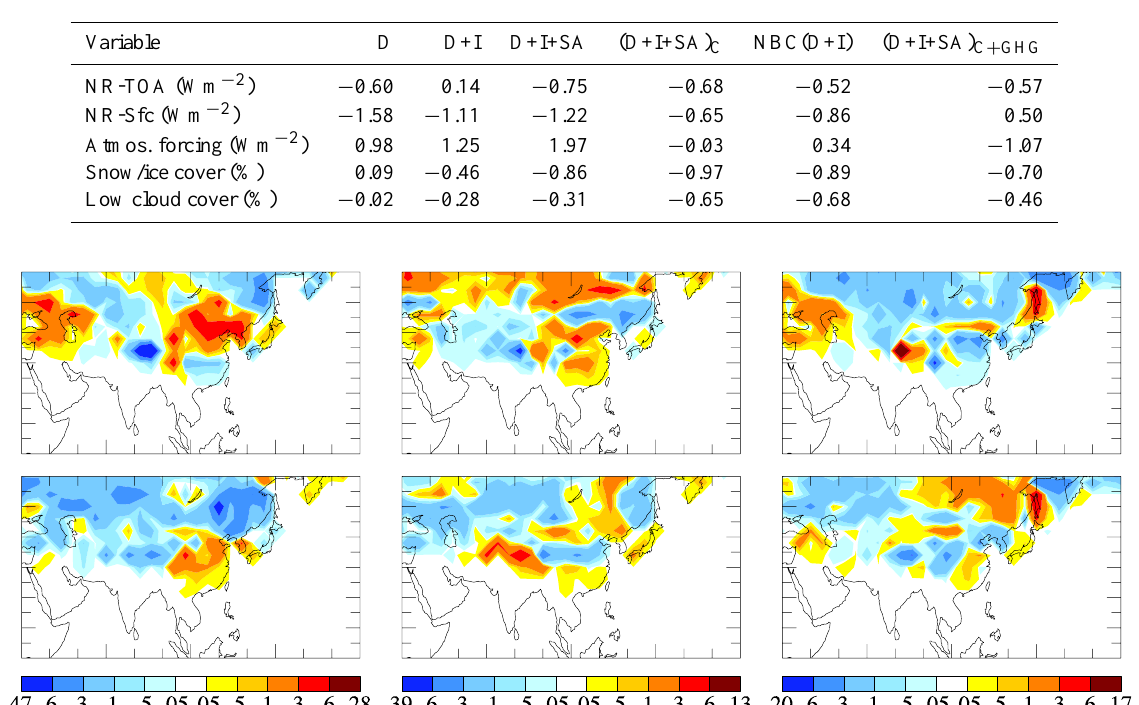
Table 5. Annual average differences in TOA net radiation (NR-TOA), surface net radiation (NR-Sfc), atmospheric forcing, snow/ice cover and low cloud cover for the Indian region (4 ◦ –40 ◦ N and 65 ◦ –105 ◦ E) for the Beig emissions for differences between simulations for changes from 1990 to 2000 for the different simulations listed in Table 1.